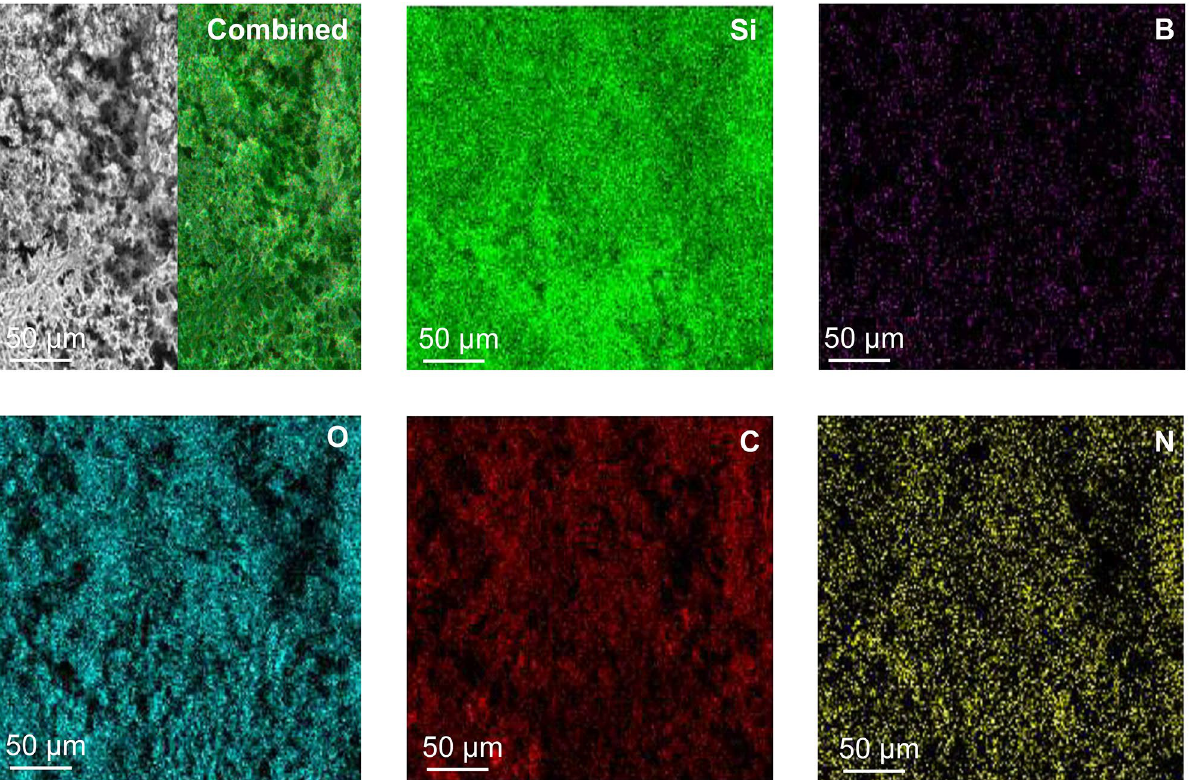
Figure 2. Low-magnification SEM image of O-SiBCN/rGO (top left panel) and the corresponding elemental and B O 4 environments compared to B C 2 N, B CN 2 and B N 3 confirming that mixing rGO and PDCs does not alter the chemical structure of the ceramic in the composite. Importantly, the absence of changes from the chemical environment of boron points out that the formation of the ceramics upon annealing does not induce any doping of the graphene support. Thermogravimetric analyses were performed on the different PDC/rGO composites in order to study their intrinsic thermal behavior during the polymer-to-ceramic conversion. The TGA curves display the weight loss of the PVZ, PBVZ and O-PBVZ when increasing the temperature up to 1000 °C under nitrogen (Fig. S2). Our results show that the addition of boron significantly decreases the weight losses of the PVZ improving the ceramic yield from 60 to 78% for PVZ and PBVZ respectively. We note that a high ceramic yield is strongly desired for the retention of the porosity, shape and structural properties of the impregnated rGO foam. Remarkably, the addition of oxygen does not drastically affect the weight loss of the PBVZ and the ceramic yield is maintained as high as 77%. Next, we characterized the structure of the rGO and O-SiBCN/rGO composites using SEM and TEM. Figure 2 shows the low-magnification SEM images and the EDX elemental mapping of the O-SiBCN/rGO composite with a 1:1 ratio. The composite exhibits clear porosity, while the presence of B, N and Si suggests the successful infiltra-